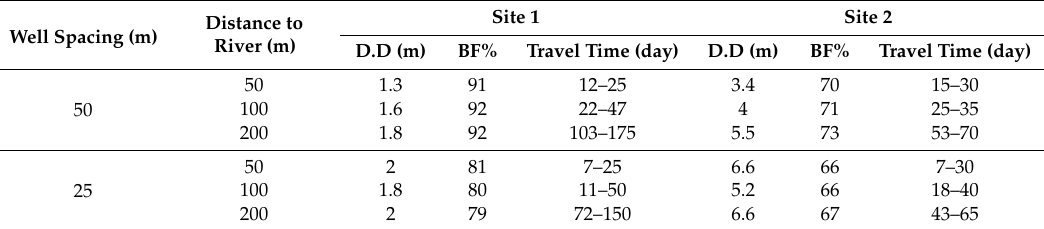
Table 1. E ff ect of well spacing on BF performance modelled parameters (i.e., bank-filtrate share BF%, drawdown D.D., and travel time) for wells placed at di ff erent distances to surface water system.